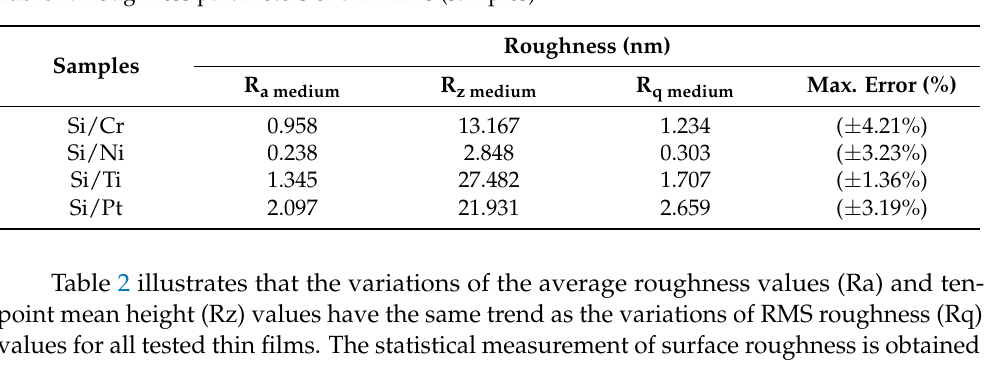
Table 2. Roughness parameters of thin films